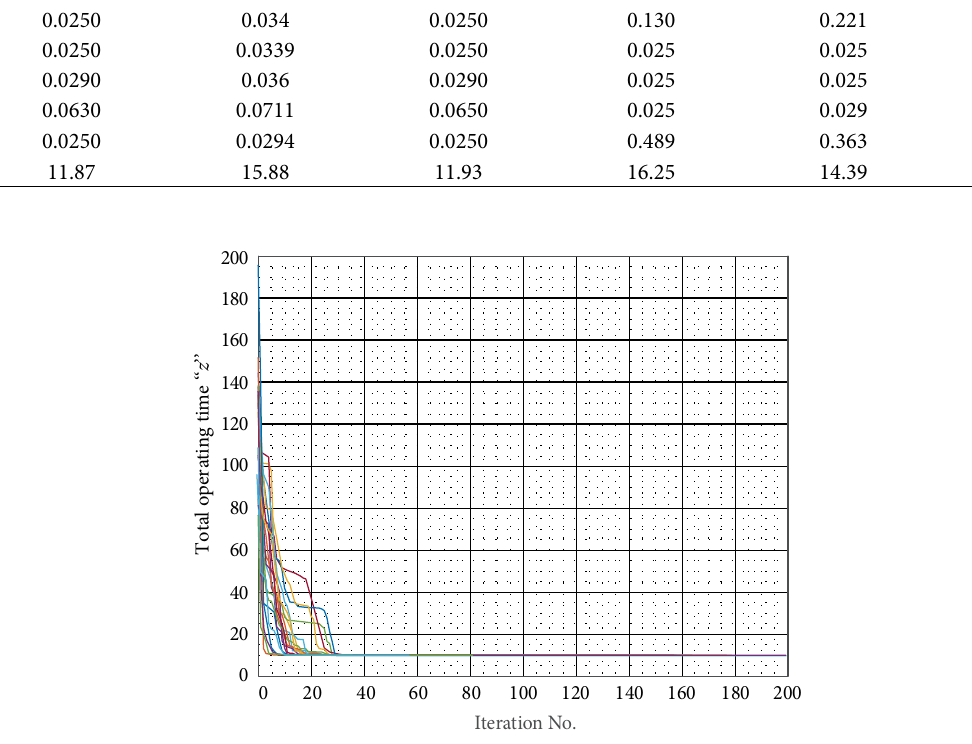
Figure 3: Convergence characteristics of JAYA for 20-time execution for Case